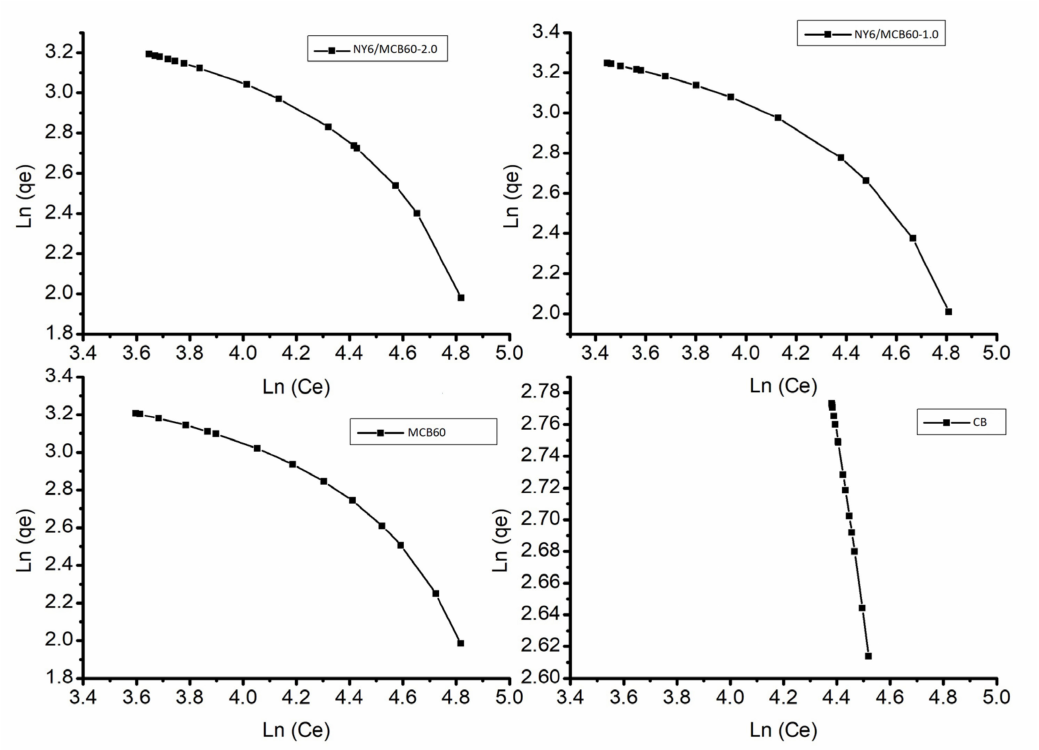
Figure 9. Langmuir and Freundlich model of adsorption for uric acid of the Nylon 6, CB, and derivatives. Table 7. Parameters of isotherm for uric acid adsorption, according to the Langmuir and Freundlich approach. Langmuir Freundlich Sample k q max R 2 n kf R 2 CB 0.14 6.66